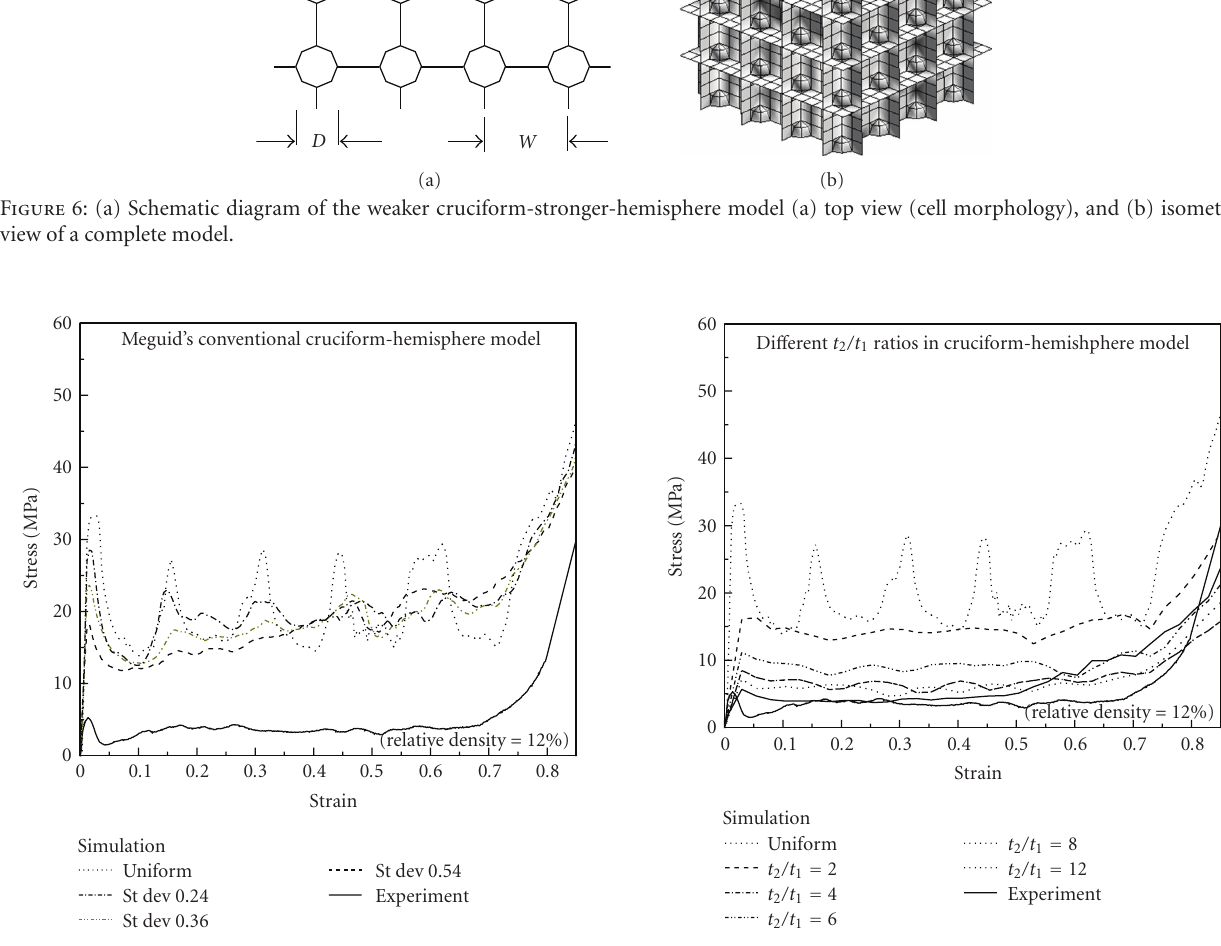
Figure 8: Variation of the stress-strain curve with change in thickness ratio in the cruciform—hemisphere